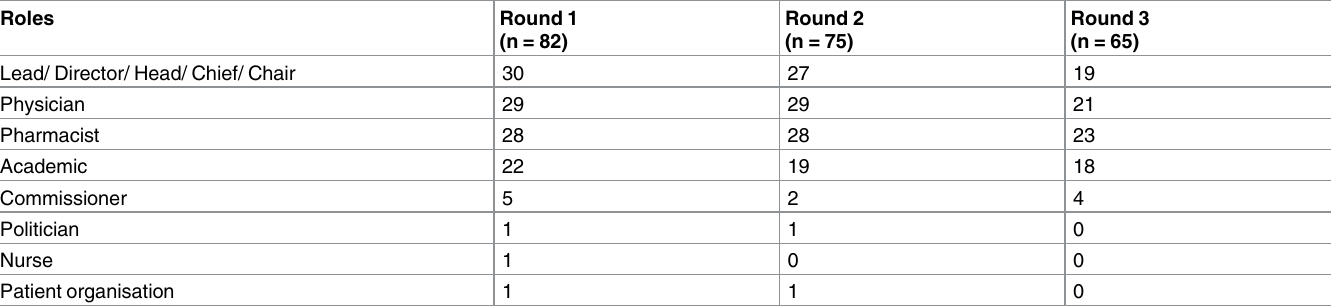
Table 2. Professional roles of Delphi panel